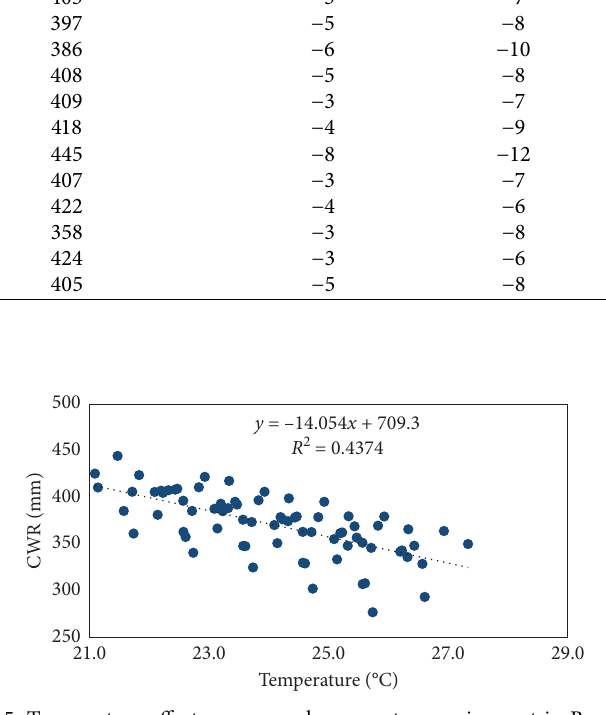
Figure 5: Temperature effect on seasonal crop water requirement in Bangladesh.